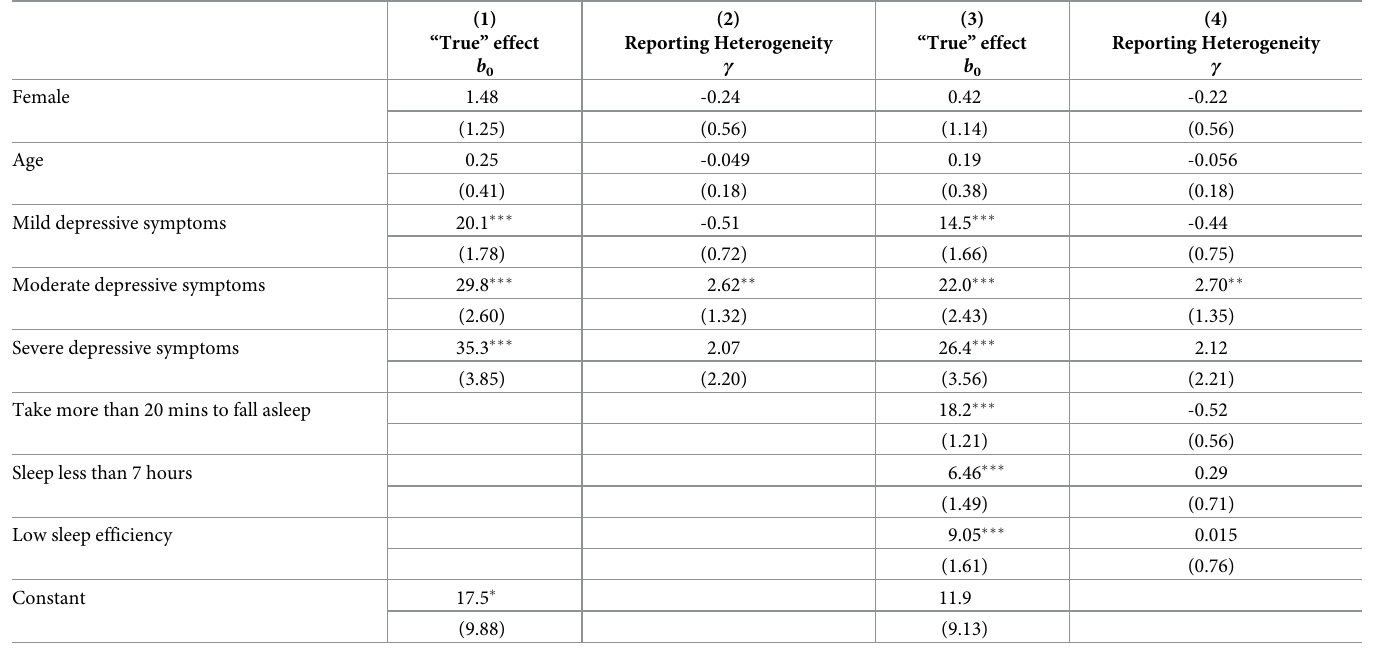
Table 5. Linear regressions of sleep difficulties on our set of control variables, accounting for reporting